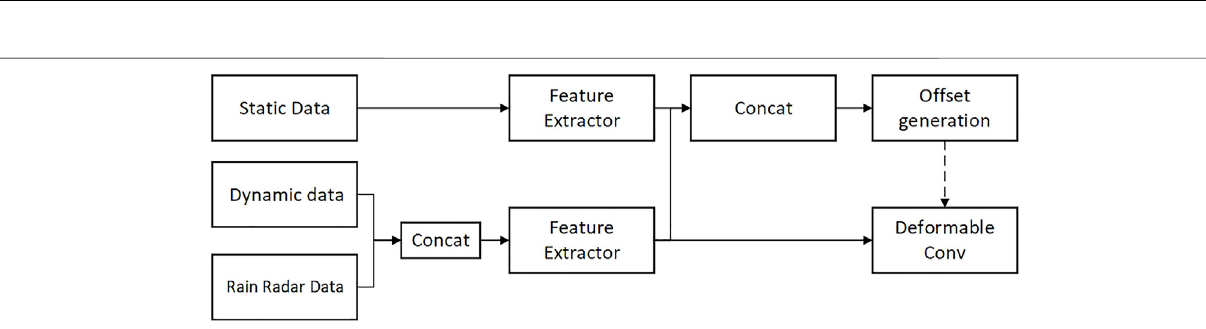
FIGURE 6 | Way of the feature